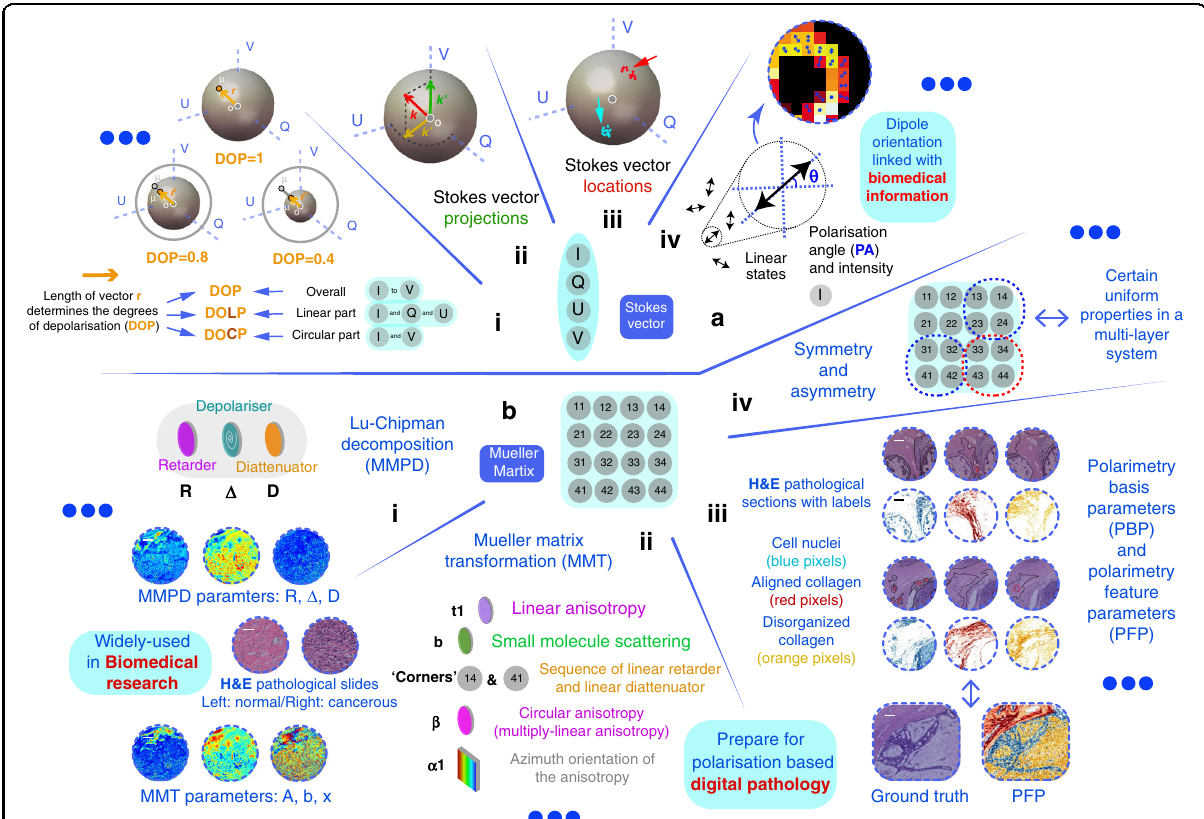
Fig. 5 Vectorial information extraction approaches. a Stokes vector based approaches: (i) DOP, DOLP and DOCP 2 – 5 ; (ii) Stokes vector projection approach 158 ; (iii) Stokes vector location approach 159 ; (iv) Dipole orientation differentiation approach. Polarisation angle (PA) and intensity are used as main parameters 154,155 . b MM based approaches: (i) MMPD method 52 : diattenuation (D), retardance (R) and depolarisation ( Δ ) (all of them maintain linear/circular components); and (ii) MMT method 57 : depolarisation (1-b; associated with small molecule scattering), level of linear anisotropy (t1), azimuth orientation of the anisotropy ( α 1), and more 179 ; (iii) PFP method 95 ; (iv) Property of symmetry and asymmetry 168,169 . (b(i)) Adapted with permission from ref. 167 © The Optical Society. (b(iii)) © [2021] IEEE. Reprinted, with permission, from ref.